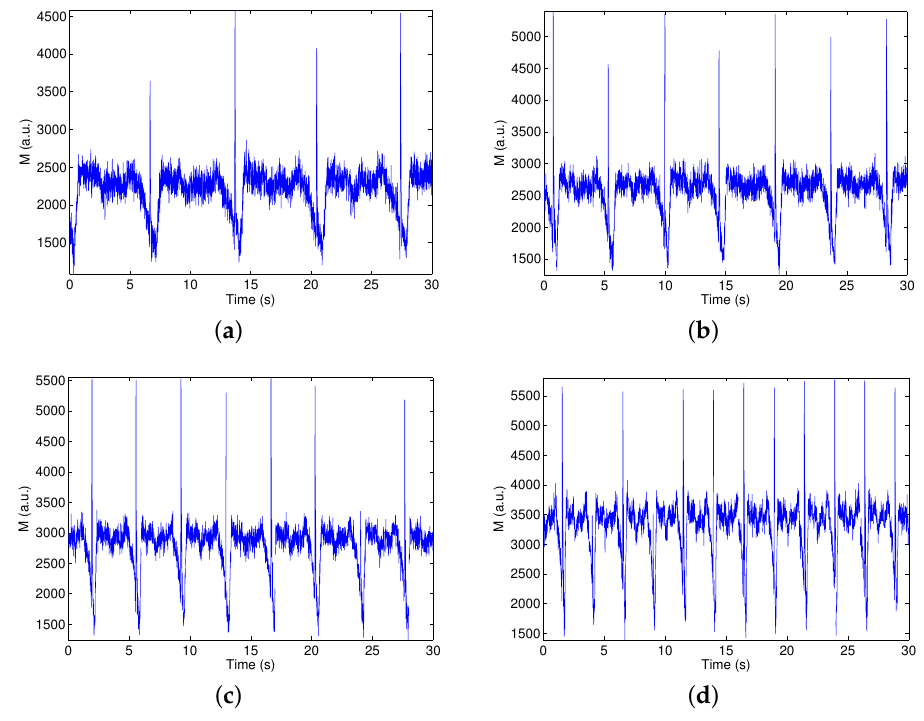
Figure 14. Evolution of the parameter M in time over 30 s for various flow rates: ( a ) potentiometer in Position 1; ( b ) potentiometer in Position 4; ( c ) potentiometer in Position 6; and ( d ) potentiometer in Position 8.